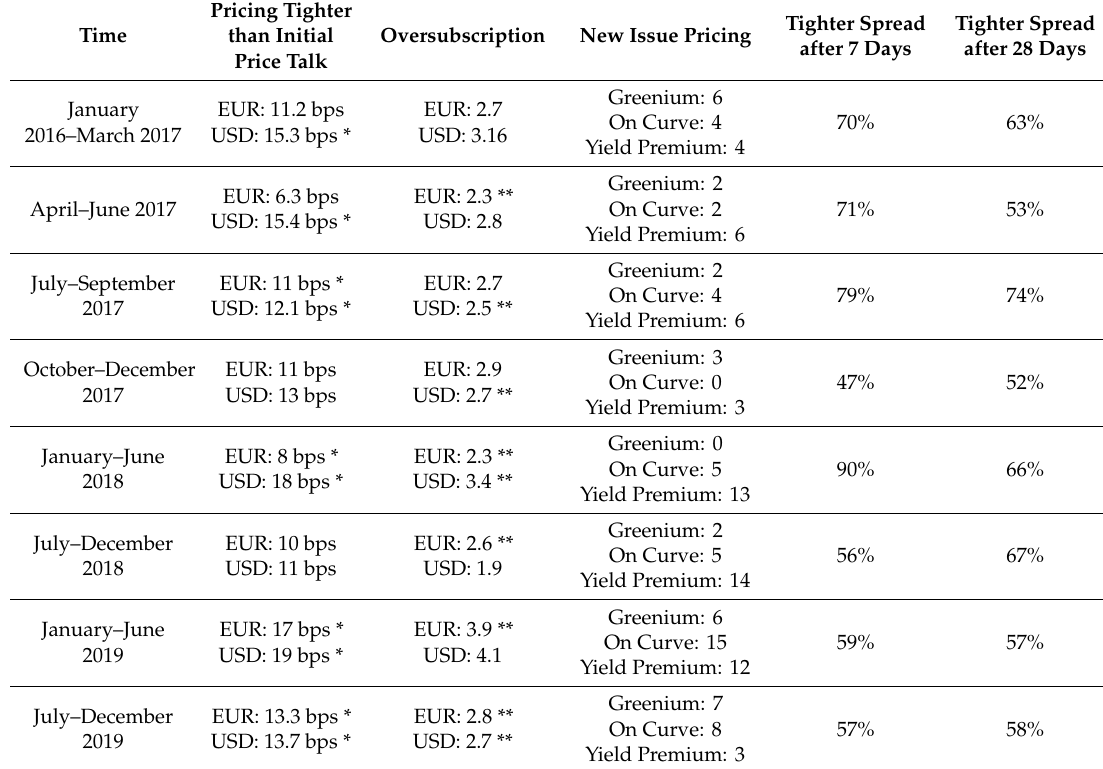
Table 3. Summary of main